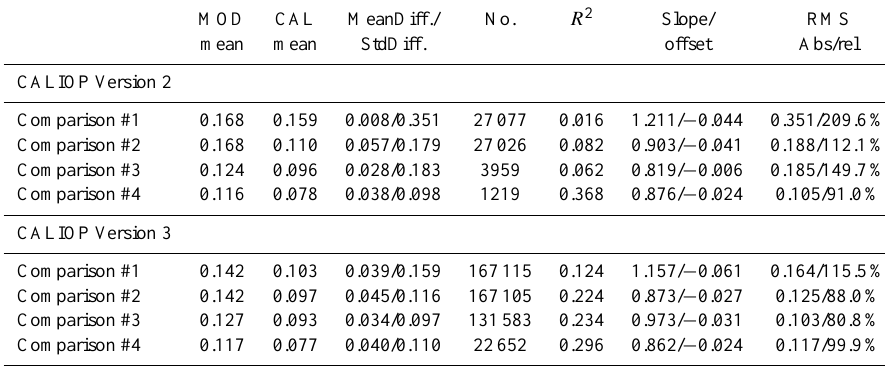
Table 8. MODIS vs. CALIOP AOD532, July 2009, over-ocean.